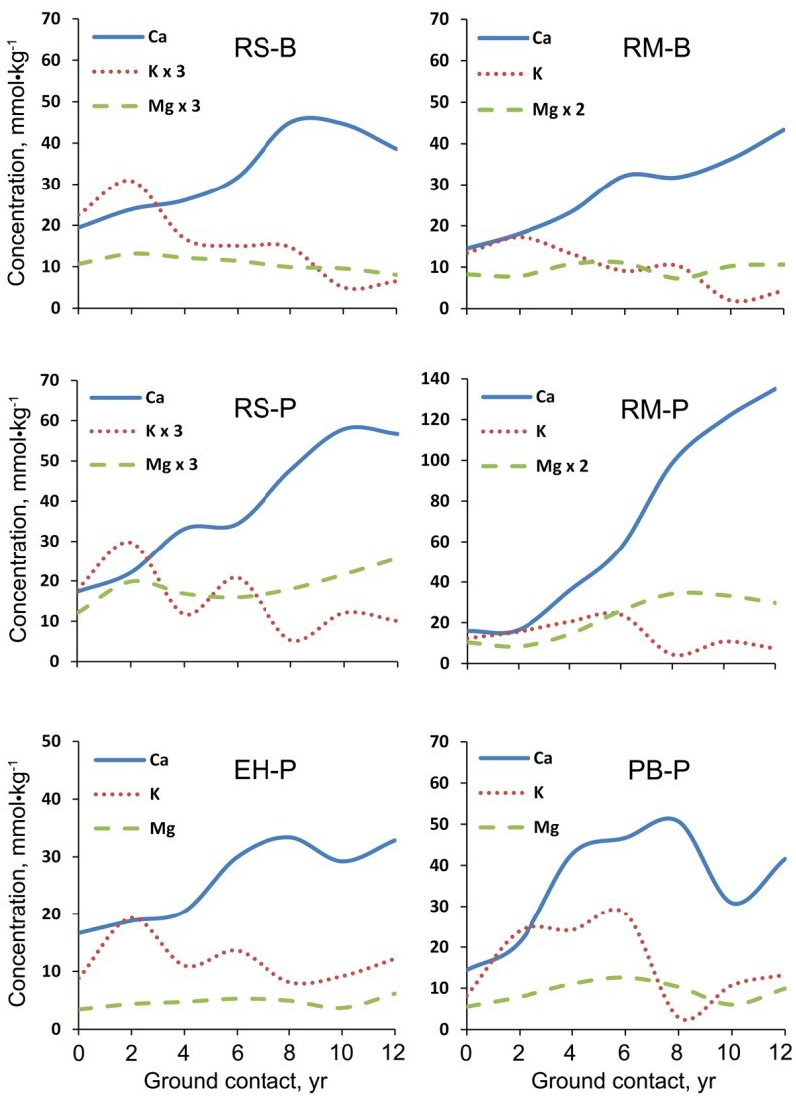
Figure 2. Pattern of mean concentration ( n = 20) of Ca, K, Mg for red spruce (RS), eastern hemlock (EH), red maple (RM), and paper birch (PB) at the Bartlett Experimental Forest